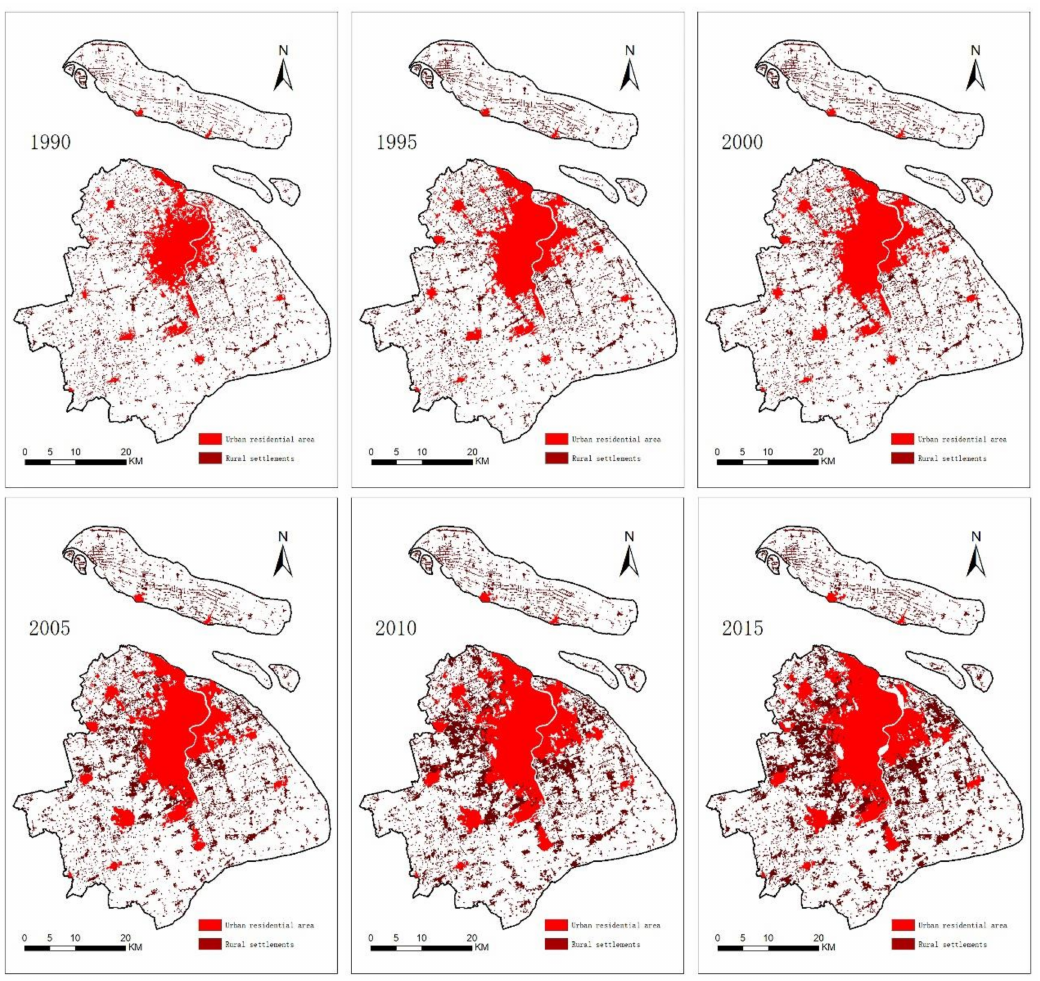
Figure 1. Spatial distribution of the urban and rural residential land area in Shanghai from 1990 to 2015. Data source: The primary data sources were downloaded from the Geographical Information Monitoring Cloud Platform (http: // www.dsac.cn /